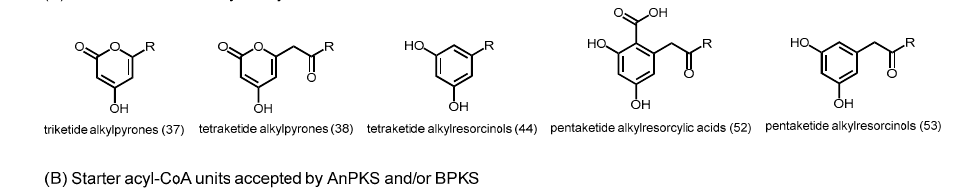
Figure 15. Substrate and product profiles of A. niger AnPKS and B. cinerea BPKS. ( A ) Products formed, and ( B ) starter acyl-CoAs accepted by the enzyme.